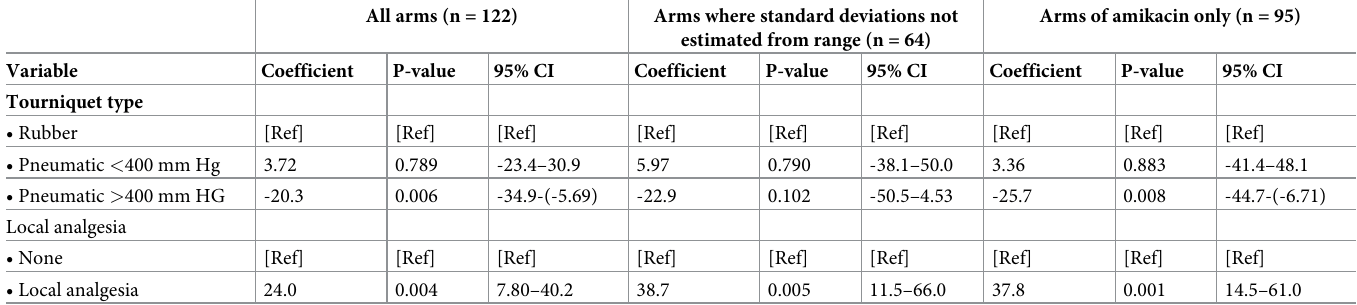
Table 2. Sensitivity analyses showed that similar trends and degrees of significance were achieved for meta-regression, regardless of the groups used. All arms (n = 122) Arms where standard deviations not estimated from range (n =